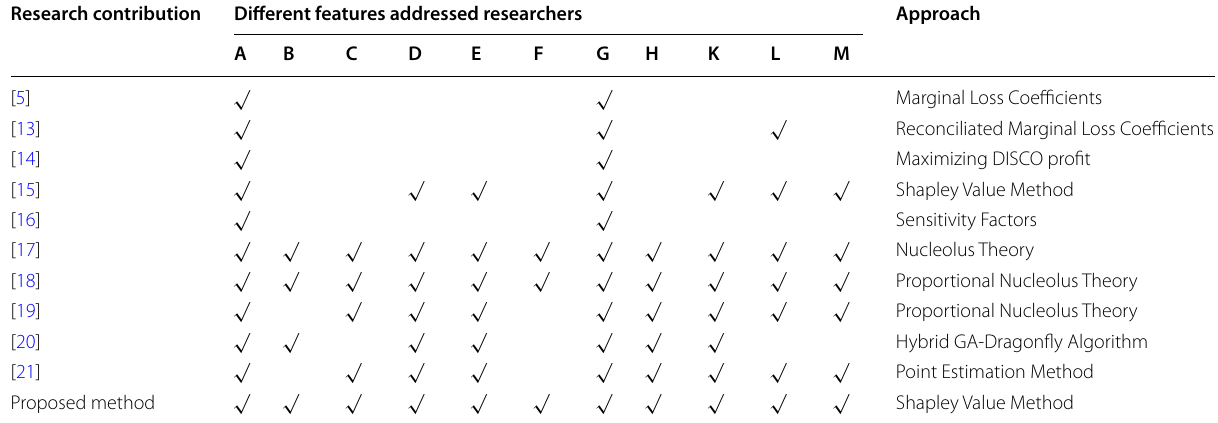
Table 1 Comparison of LMP computation features Research